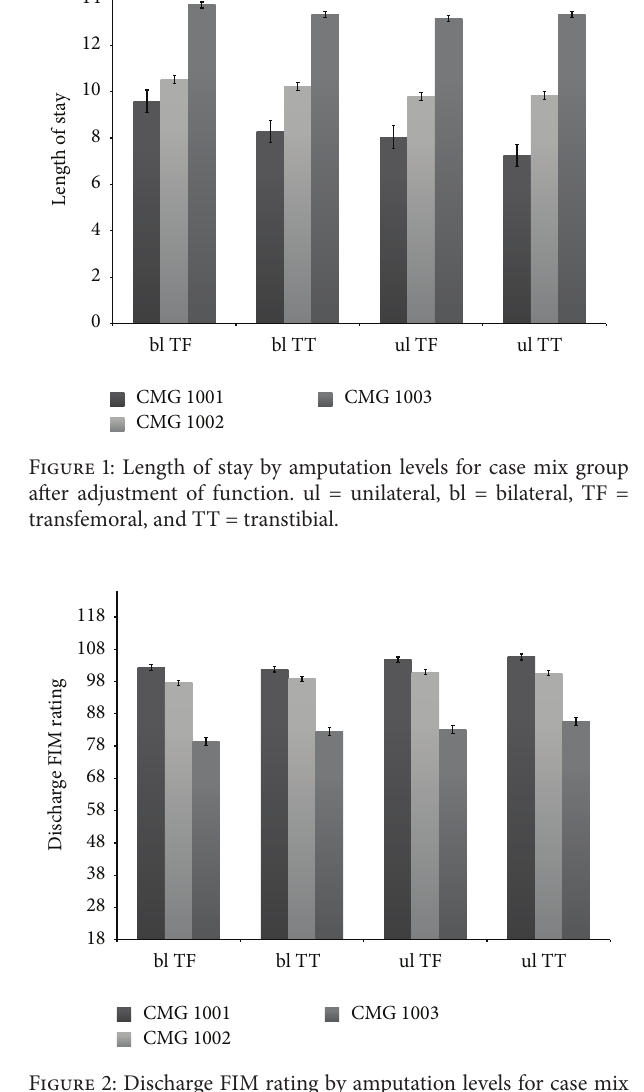
Figure 2: Discharge FIM rating by amputation levels for case mix group after adjustment of function. ul = unilateral, bl = bilateral, TF = transfemoral, and TT =